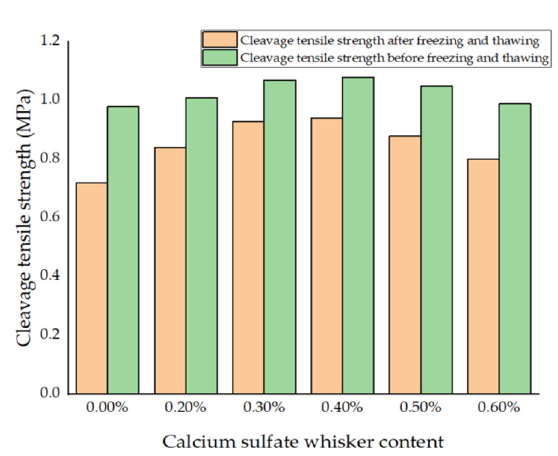
Figure 7. Freeze-thaw splitting test results of calcium sulfate whisker asphalt mixture.